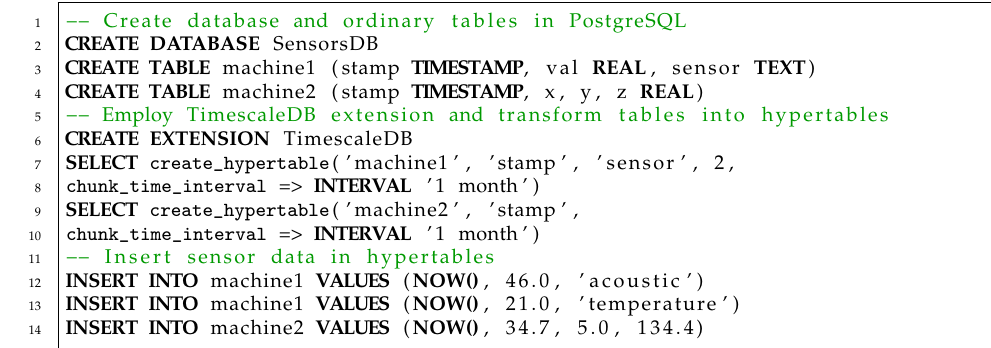
Figure 10. Create a sensor database in